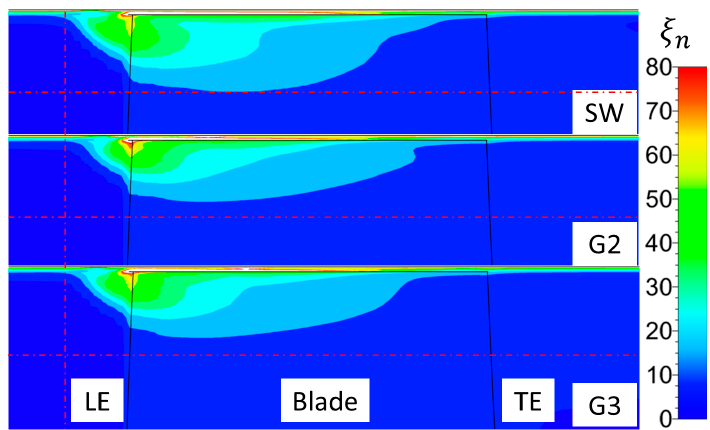
Figure 9. Time-averaged and pitch-averaged absolute vorticity contours on the meridional plane in the tip region of R2.